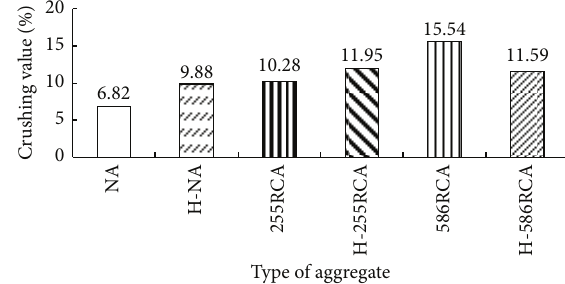
Figure 3: Crushing values of various types of